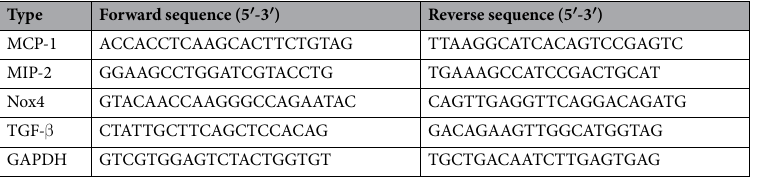
Table 1. Primers used in the